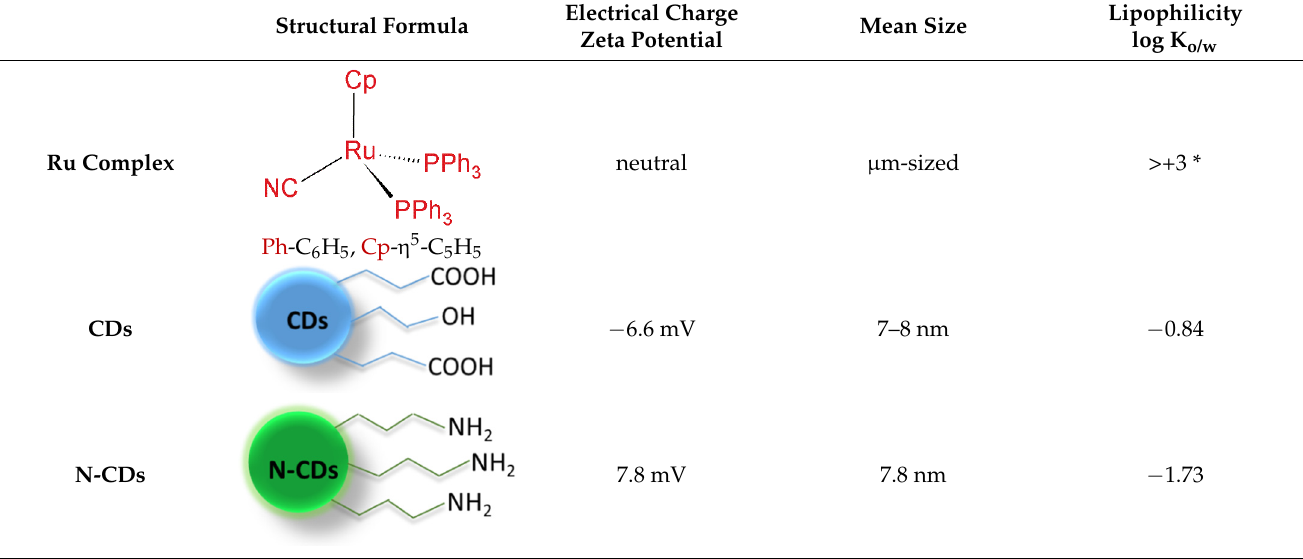
Figure 1. ( a ) Cell metabolic activity after the indicated treatments is expressed as a percentage of the nontreated cells (control) (the mean ± SD). Statistical significance was determined using the ANOVA test. ns, not significant, p > 0.05; ****, significant, p < 0.0001. ( b ) A microscopic image shows the original morphology of treated A2780 cancer cells. The microscopic images of control and cells with all treatment conditions are presented in Figure S2. Table 1. Molecular representation and physicochemical properties (zeta potential, mean size, and partition coefficients) of nanocarriers CDs and N-CDs.